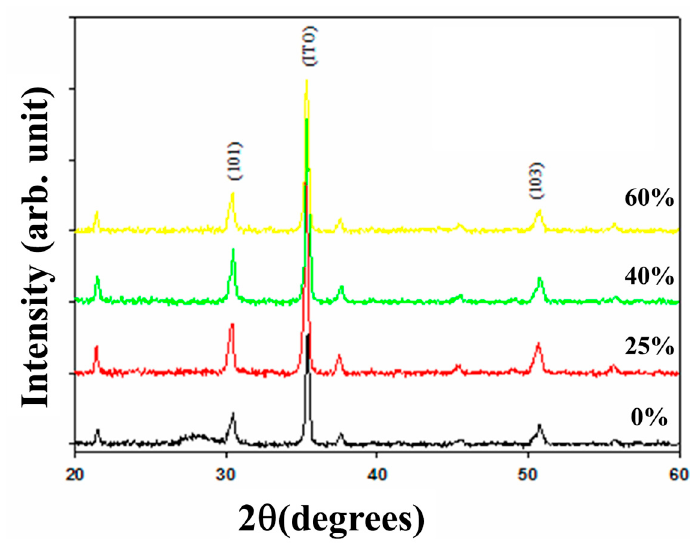
Figure 1. The X-ray diffraction (XRD) patterns of the neodymium oxide thin films for the different oxygen concentration parameters.